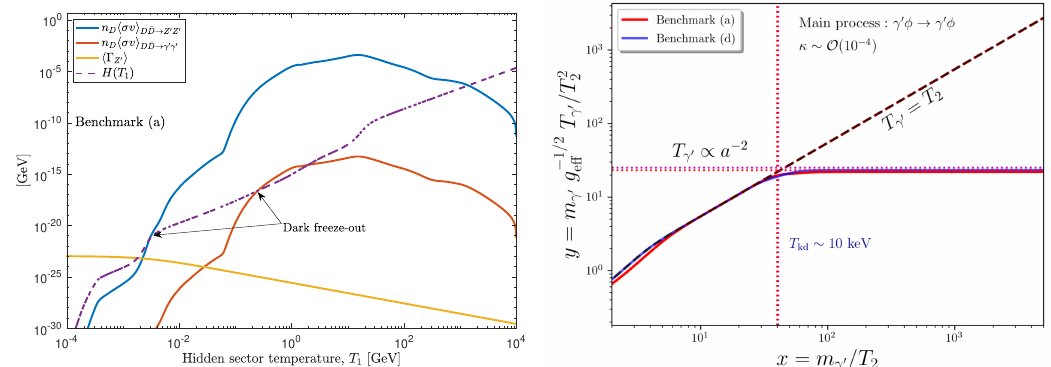
Figure 5 . Left panel: a plot of n h σv i for the dominant processes in the hidden sector along with the Hubble parameter and the thermally averaged decay width of Z 0 . Right panel: the temperature of kinetic decoupling of γ 0 for benchmarks (a) and (d). The dark photon temperature traces that of the thermal bath before decoupling at around 10